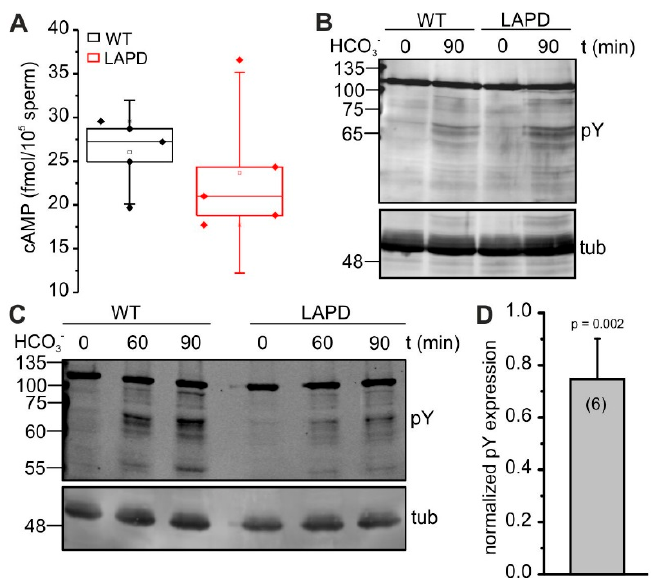
Figure 3. Analysis of LAPD function in mouse sperm. ( A ) Total cAMP content in wild-type (WT) and Prm1-LAPD sperm after stimulation with 690 nm light for 5 min. Data are shown as box plots, containing individual data points and mean ± SD (Per 25 / 75). ( B ) Western blot analysis of protein tyrosine phosphorylation. Tyrosine phosphorylation after stimulation with 25 mM NaHCO 3 for 0 and 90 min in the dark in wild-type (WT) and Prm1-LAPD (LAPD) sperm was detected with a phospho-tyrosine antibody (pY). Alpha-tubulin was used as loading control. ( C ) See (B) after continuous white light stimulation for 0, 60, and 90 min. ( D ) Quantification of protein tyrosine phosphorylation in Prm1-LAPD sperm, relative to wild-type sperm (set to 1), after 90 min bicarbonate incubation under 660 nm illumination. Data were normalized to the WT. Data are shown as mean + SD, n number is indicated .